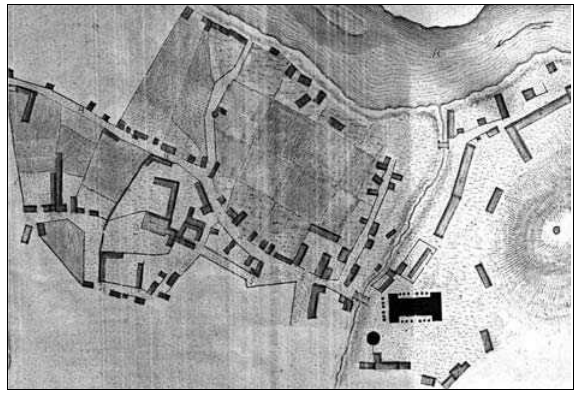
Fig. 6. teritory of present Gediminas avenue. Fragment of plan in 1805 (Vilniaus ... 1805)